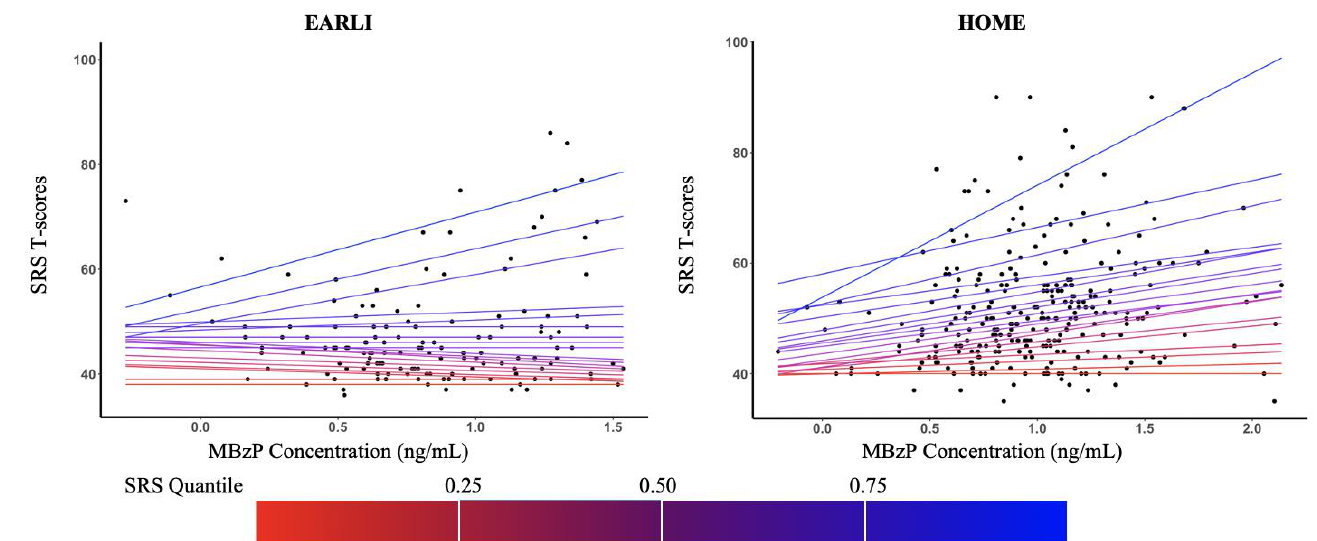
Figure 2. Adjusted differences in children’s SRS T-scores at Ages 3 to 8 per 10-fold increase in gestational urinary monobenzyl phthalate (MBzP) concentration from 0.05–0.95 (at intervals of 0.05) quantiles of SRS T-scores: the EARLI (2009–2012) and HOME Studies (2003–2006). EARLI: Early Autism Risk Longitudinal Investigation Study, HOME: Health Outcomes and Measures of the Environment Study, SRS: Social Responsiveness Scale, mono-isobutyl phthalate; MBzP. Adjusted for maternal age (continuous), maternal race (white vs. non-white), income (<$30,000 vs. $30,000–$75,000, ≥$75,000), parity (continuous), and log10-transformed urine/serum cotinine concentrations (continuous). Note cotinine concentrations were measured in maternal urine in EARLI and serum in HOME. Positive slope for SRS indicate that maternal phthalate exposure is associated with more deficits in social responsiveness traits. Quantile sequence 0.05–0.95 by 0.05.